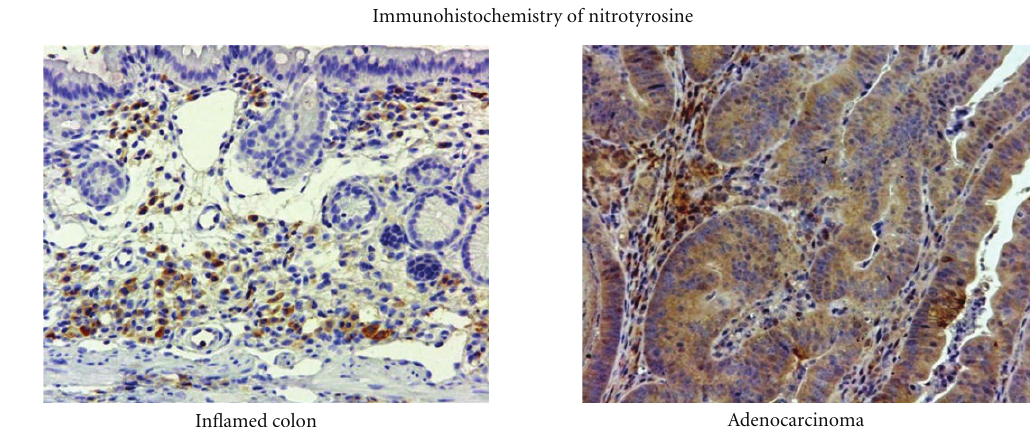
Figure 11: Scores of nitrotyrosine-positivity and inflammation in the inflamed colon and colonic tubular adenocarcinoma.